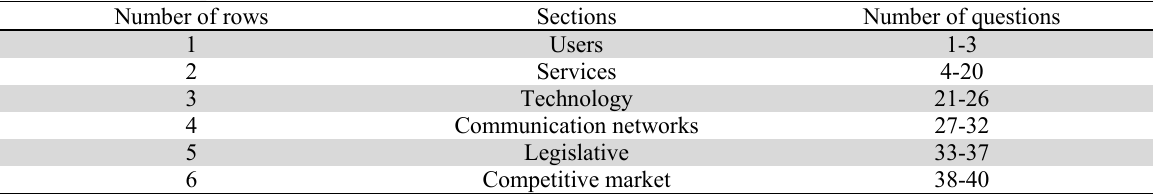
Table 1 Classification of questions in six sections